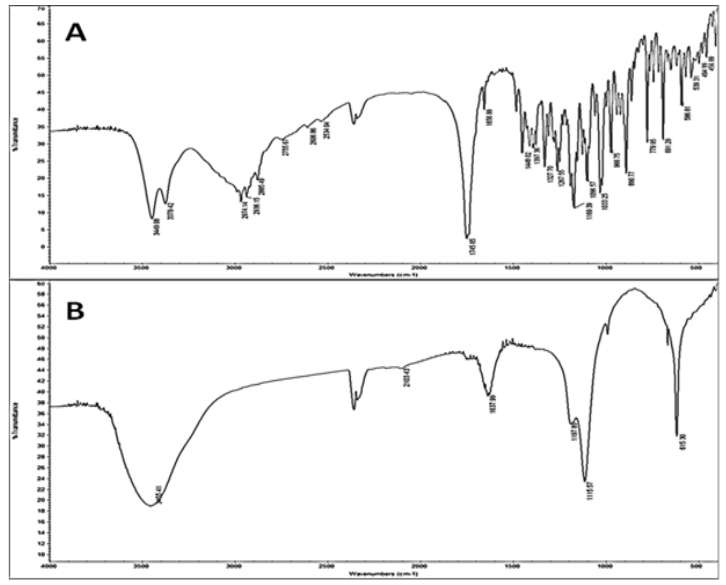
Fig. 4. FT-IR spectra of standard gibberellic acid (A) and extracted gibberellic acid